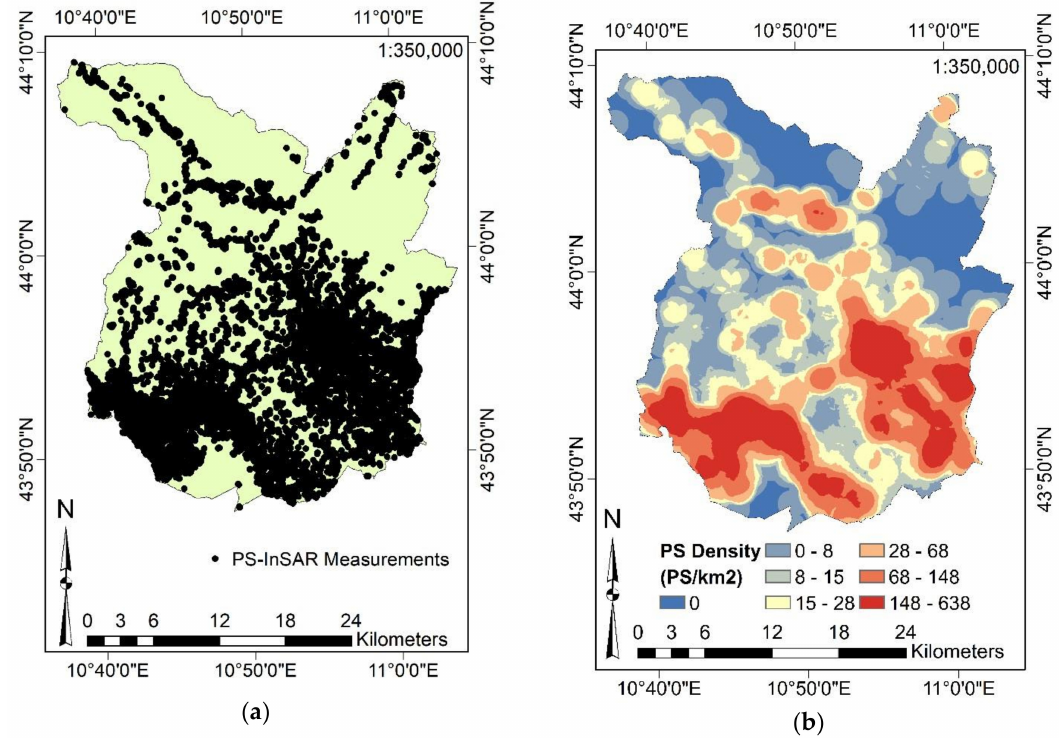
Figure 5. Persistent Scatterer (PS) measurements over the study area (52,257 PS): ( a ) Localization of PS. ( b ) PS density. Adapted from Fiorentini et al.